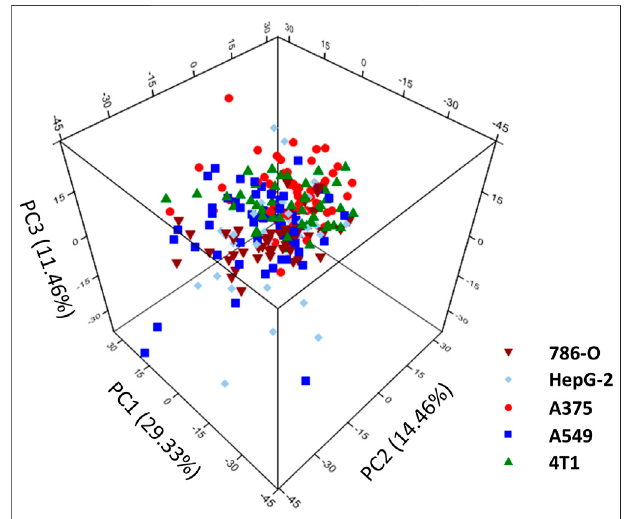
FIGURE 4 | The top three PCs ’ score plot of different cancer